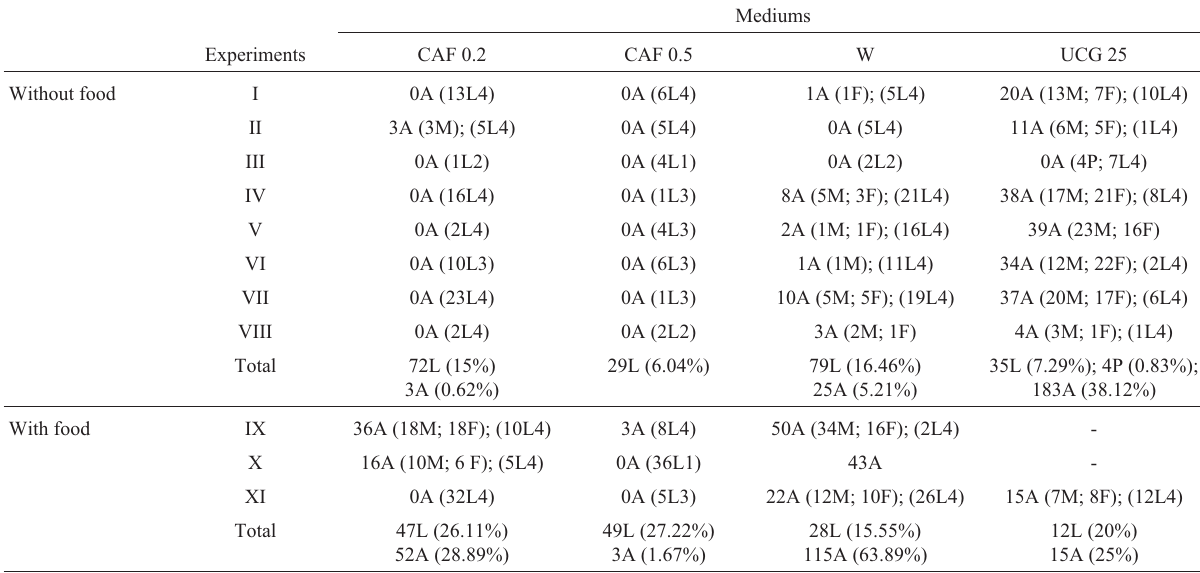
Table 2 - Results of experiments using eggs, without and with addition of food. Number of mosquitoes obtained in the different developmental stages. Mediums: caffeine (CAF) at 0.2 mg/mL and 0.5 mg/mL, water (W; control) and used coffee grounds (UCG) at 25 mg/mL. L1 to L4 = larval stages; P = pupae; A = adults; - = treatment not carried out. Sixty eggs were used per treatment, in each experiment.